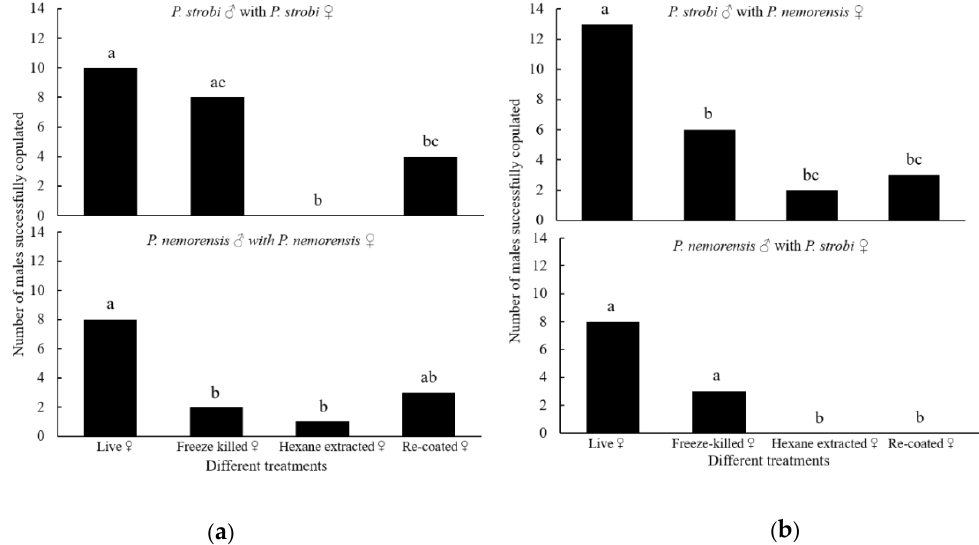
Figure 1. The numbers of male Pissodes strobi and Pissodes nemorensis that copulated with intraspecific ( a ) and interspecific ( b ) live females, freeze-killed females, hexane-extracted female carcasses, and recoated female carcasses. For each test, n = 20. Different lowercase letters above the bars indicate significant differences among treatments at α = 0.05 by χ2 or Fisher exact tests.